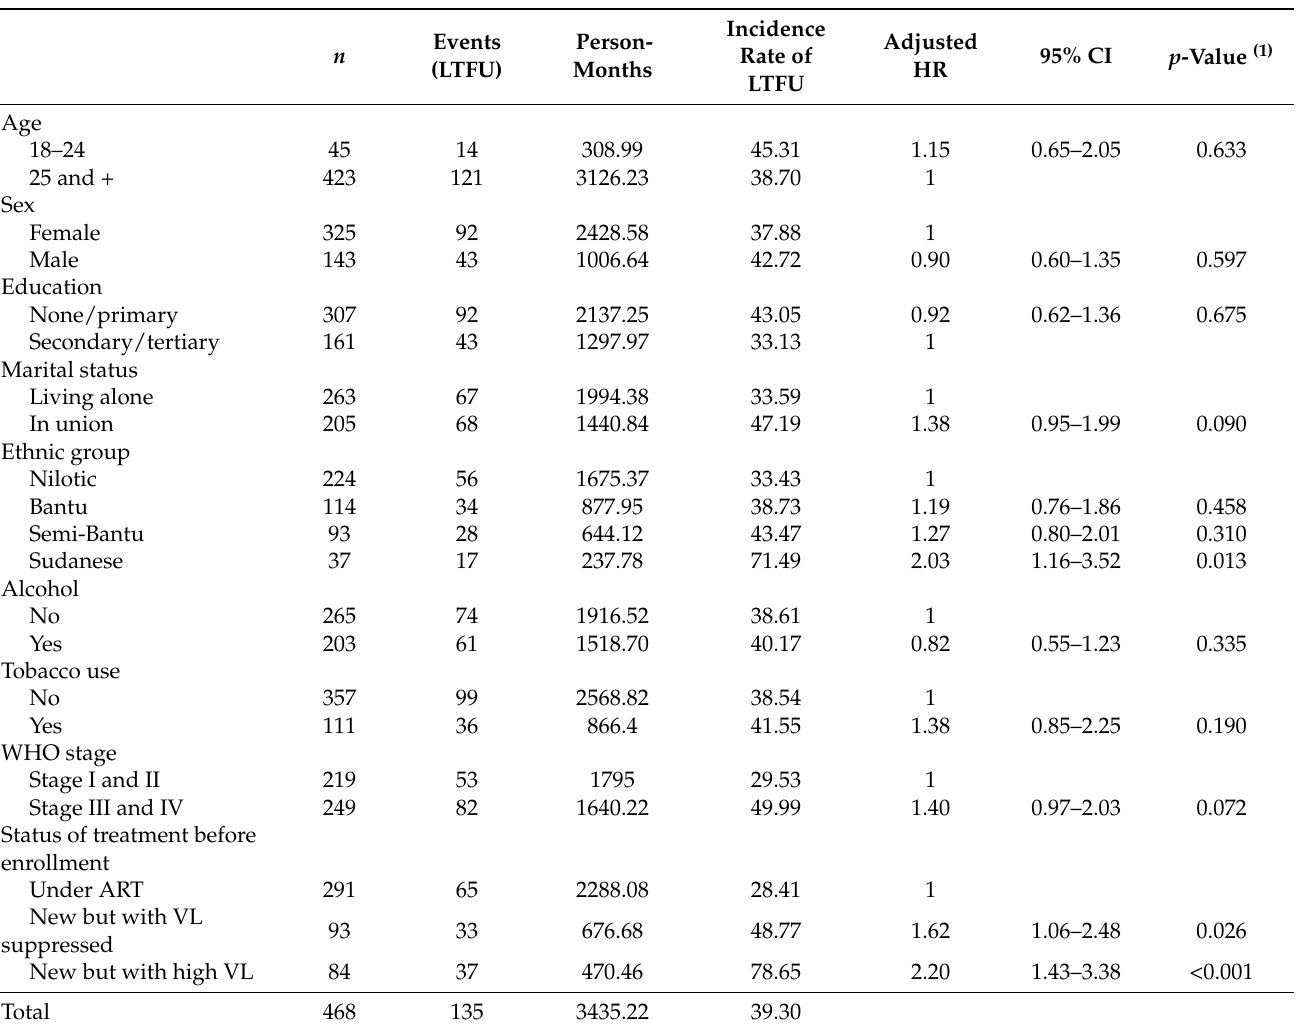
Table 2. Multivariate analysis of predictors of